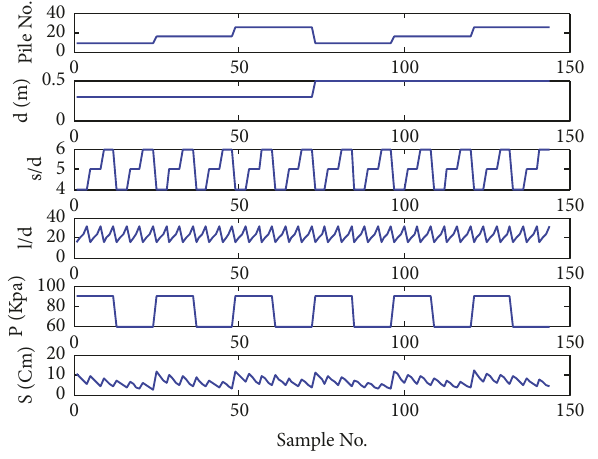
Figure 2: Input and output data used.